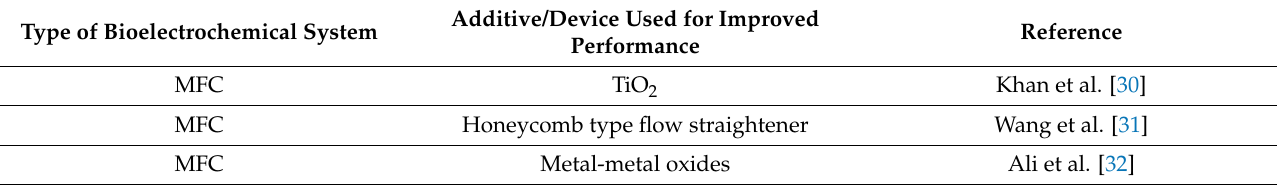
Table 1. Recent studies on MFCs. Additive/Device Used for Improved Type of Bioelectrochemical System Reference Performance MFC TiO 2 Khan et al. [30] MFC Honeycomb type flow straightener Wang et al. [31] MFC Metal-metal oxides Ali et al.